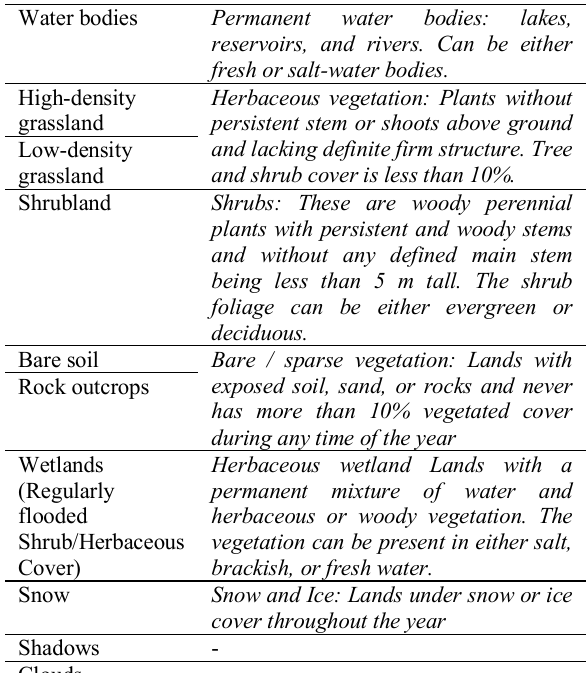
Table 1. The Land Cover